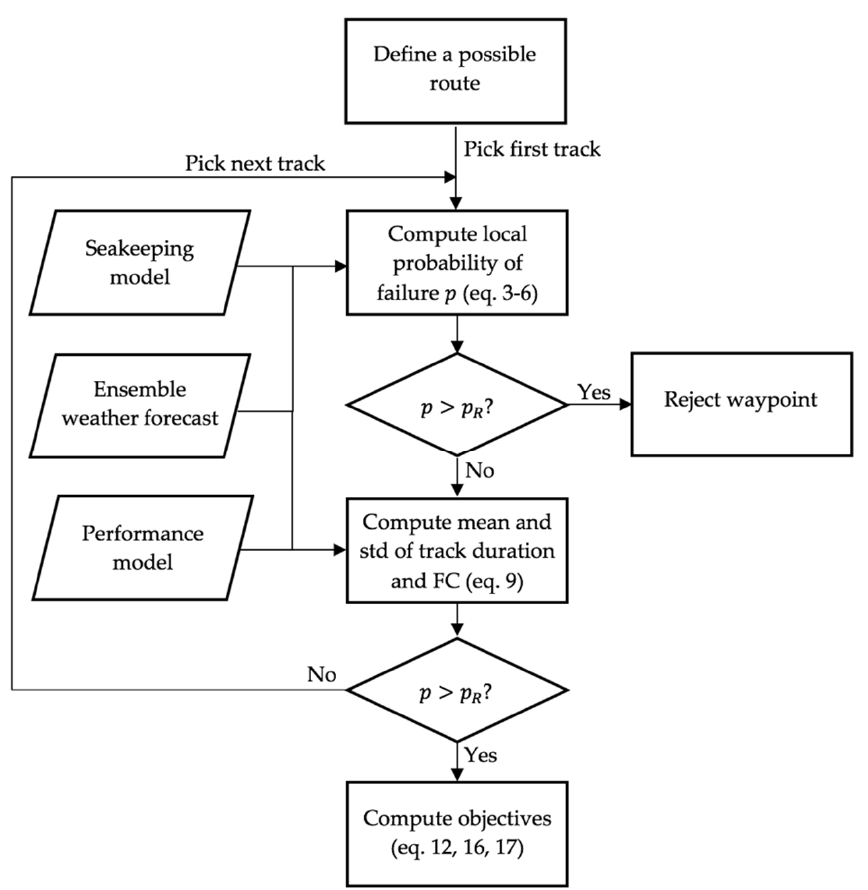
Figure 2. Flowchart of the calculation process.